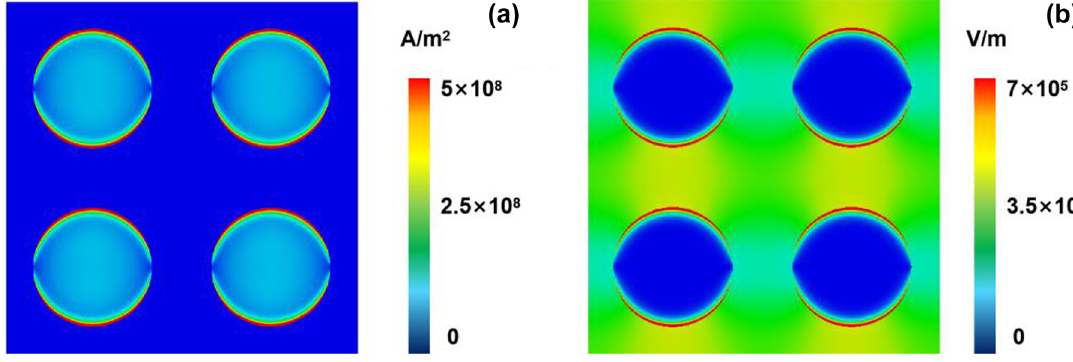
Figure 6: Simulation results. (a) Surface current distribution of the devices, (b) electric field